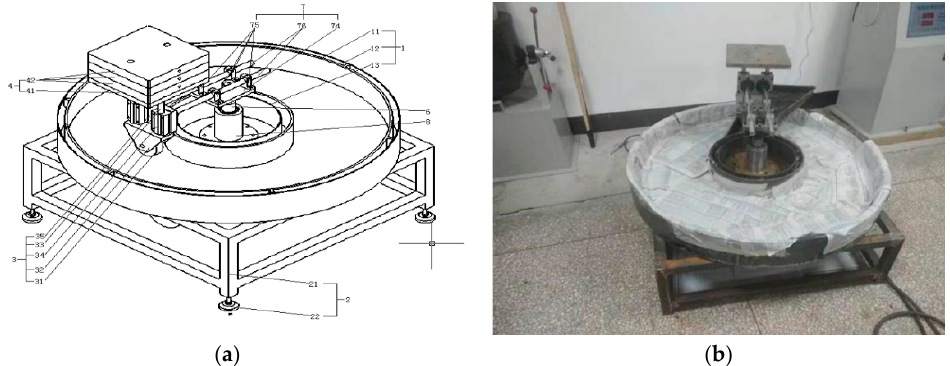
Figure 3. ( a ) Schematic diagram of the new rutting tester. ( b ) Physical image of the new rutting test. ① disc; ② bracket at the lower part of the disc; ③ driving wheel frame device; ④ counterweight; ⑤ reduction gear; ⑥ transmission shaft; ⑦ cantilever bracket; ⑧ rotating shaft; ⑨ heating de- vice; ⑩ controller.